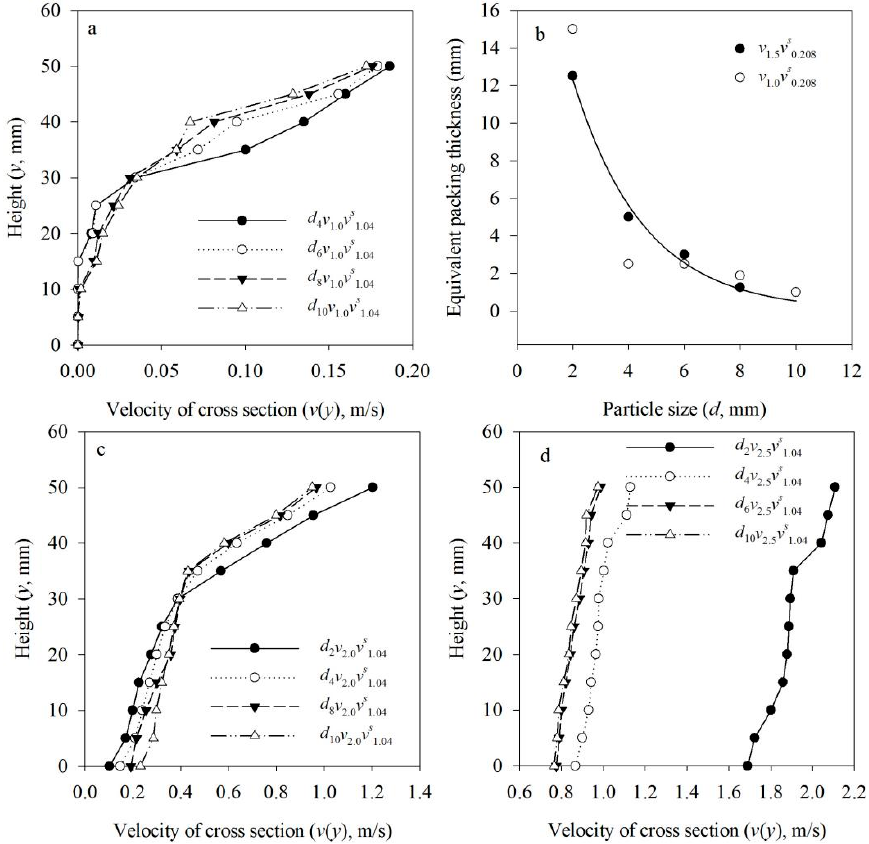
Figure 8. Particle size and vertical velocity distribution of particles. ( a ) the relationship between vertical velocity distribution and particle size in aggregate transportation; ( b ) aggregate transporta- tion, equivalent packing thickness and particle size relationship; ( c ) the relationship between vertical velocity distribution and particle size in saltation transport; ( d ) the relationship between vertical velocity distribution and particle size in suspended transport.